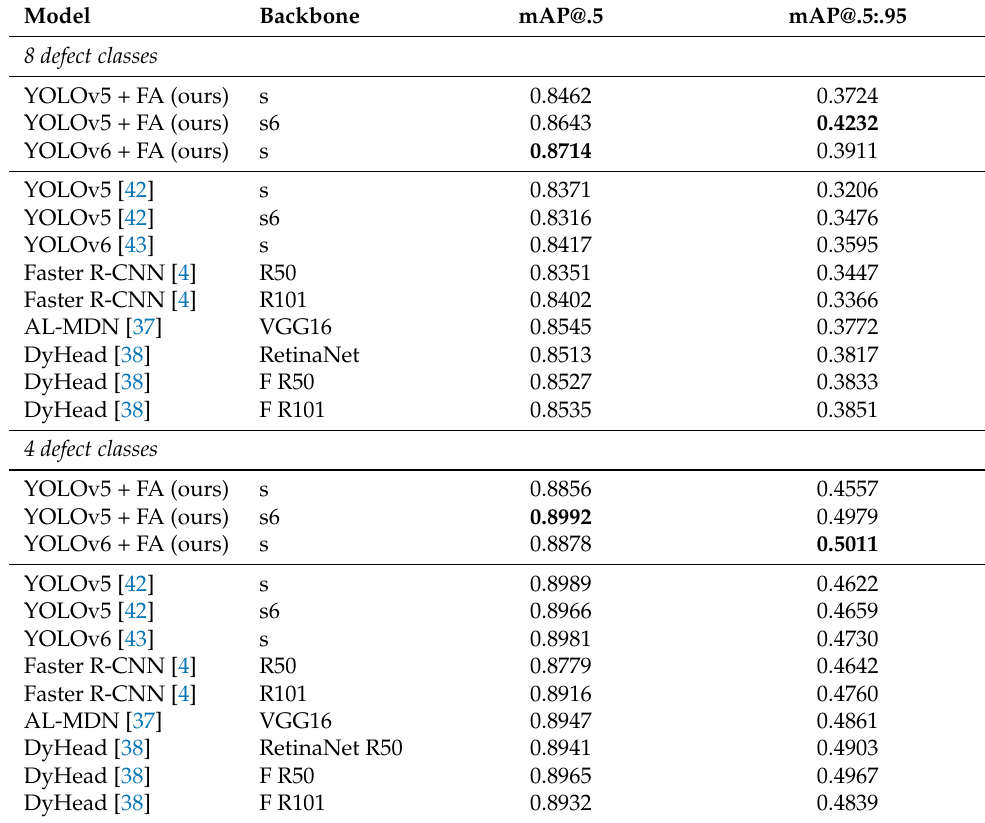
Table 2. Detection results of different methods over the rail defect validation dataset. Model Backbone mAP@.5